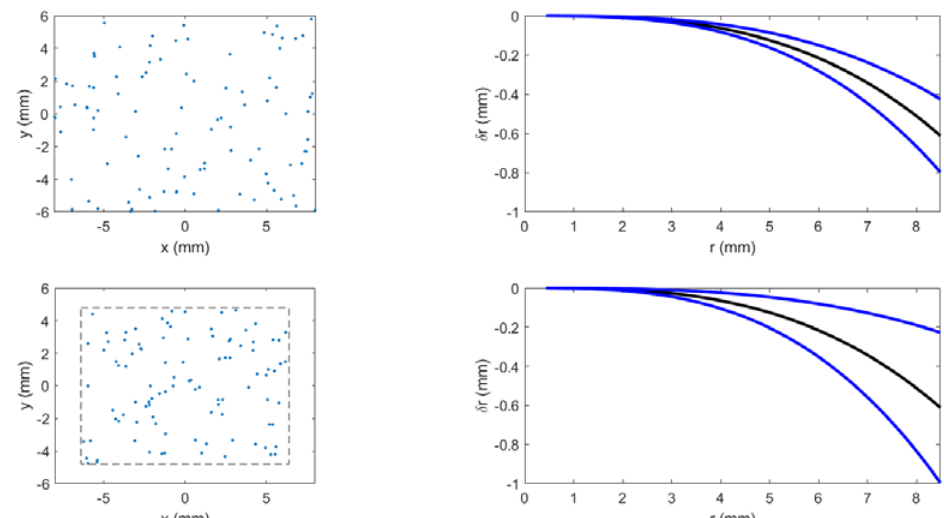
Figure 1. Lens distortion curve fit example. Top left: image points distributed throughout the image plane. Top right: estimated distortion curve (black) and 1 σ envelope (blue). Bottom left: image points covering 80% of the format. Bottom right: distortion curve (black) and 1 σ envelope with exaggerated scale